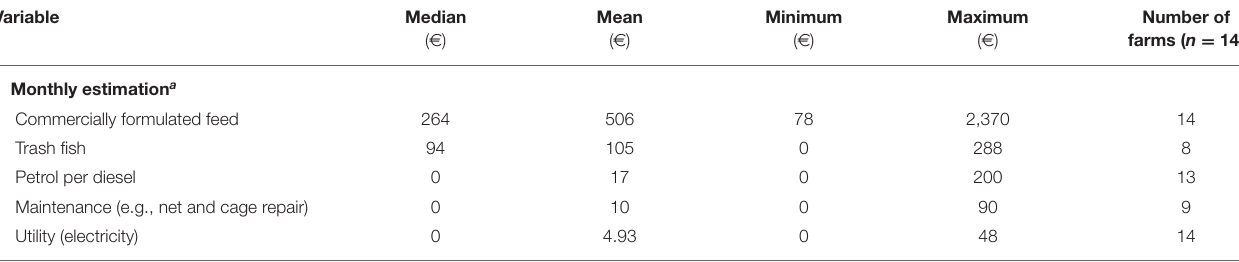
TABLE 8 | Descriptive results of continuous data on operational costs per